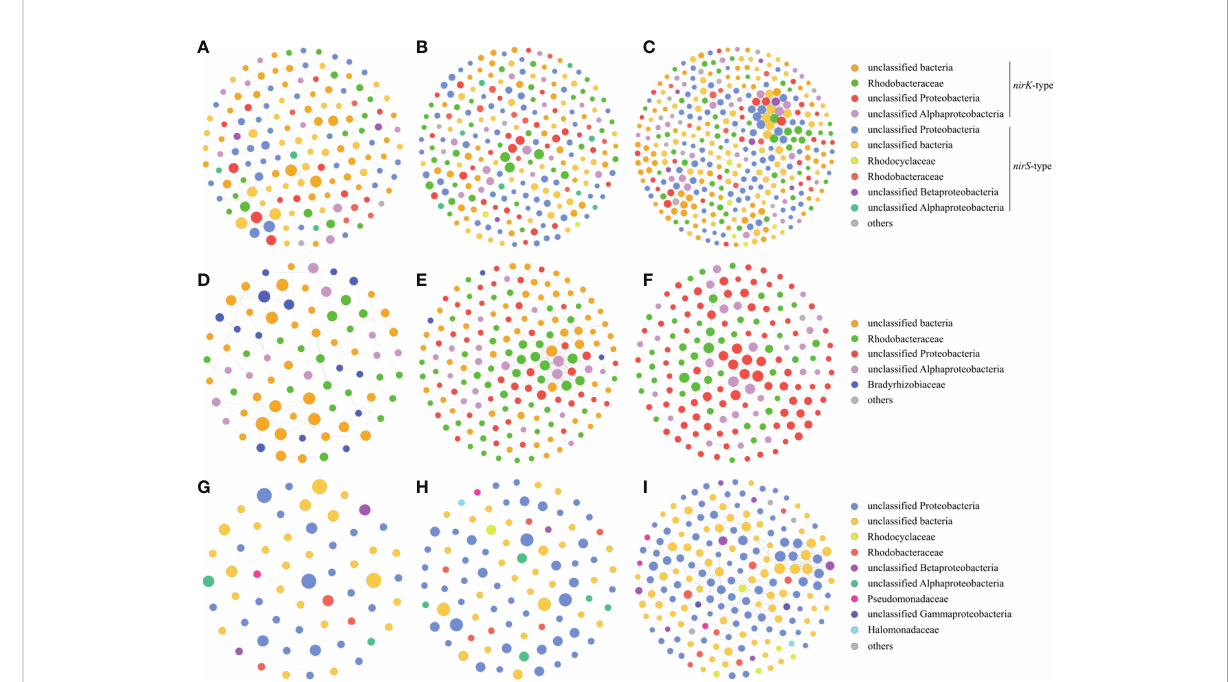
FIGURE 9 Co-occurrence networks of the denitrifying bacteria during the green tide (A) , the outbreak phase (B) and the decline phase (C) , co-occurrence networks of the nirK -type denitrifying bacteria during the green tide (D) , the outbreak phase (E) and the decline phase (F) , and co-occurrence networks of the nirS -type denitrifying bacteria during the green tide (G) , the outbreak phase (H) and the decline phase (I)